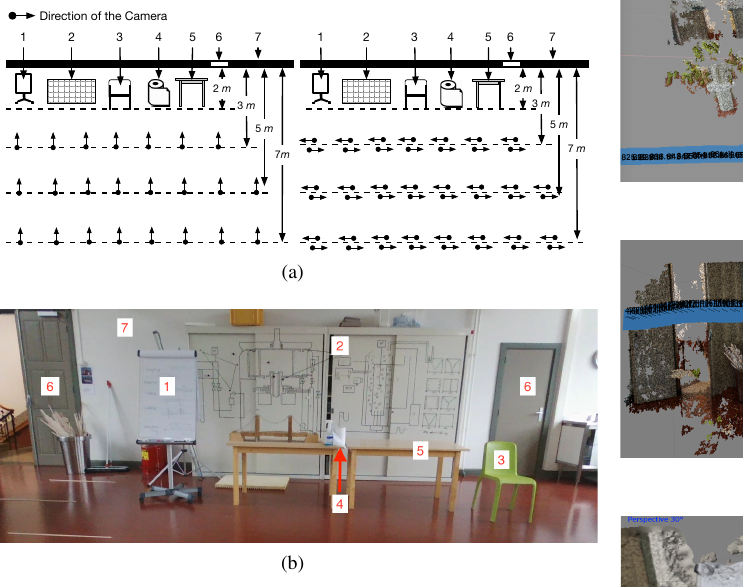
Figure 7. Forward-facing view of flight paths for parameter estimations.